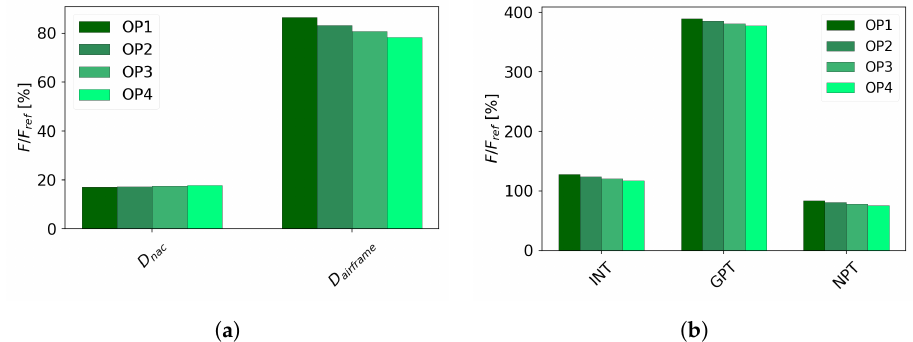
Figure 9. Variation of propulsive forces along the integrated cruise segment. All data are normalised by the net force at OP1. ( a ) Drag; ( b )